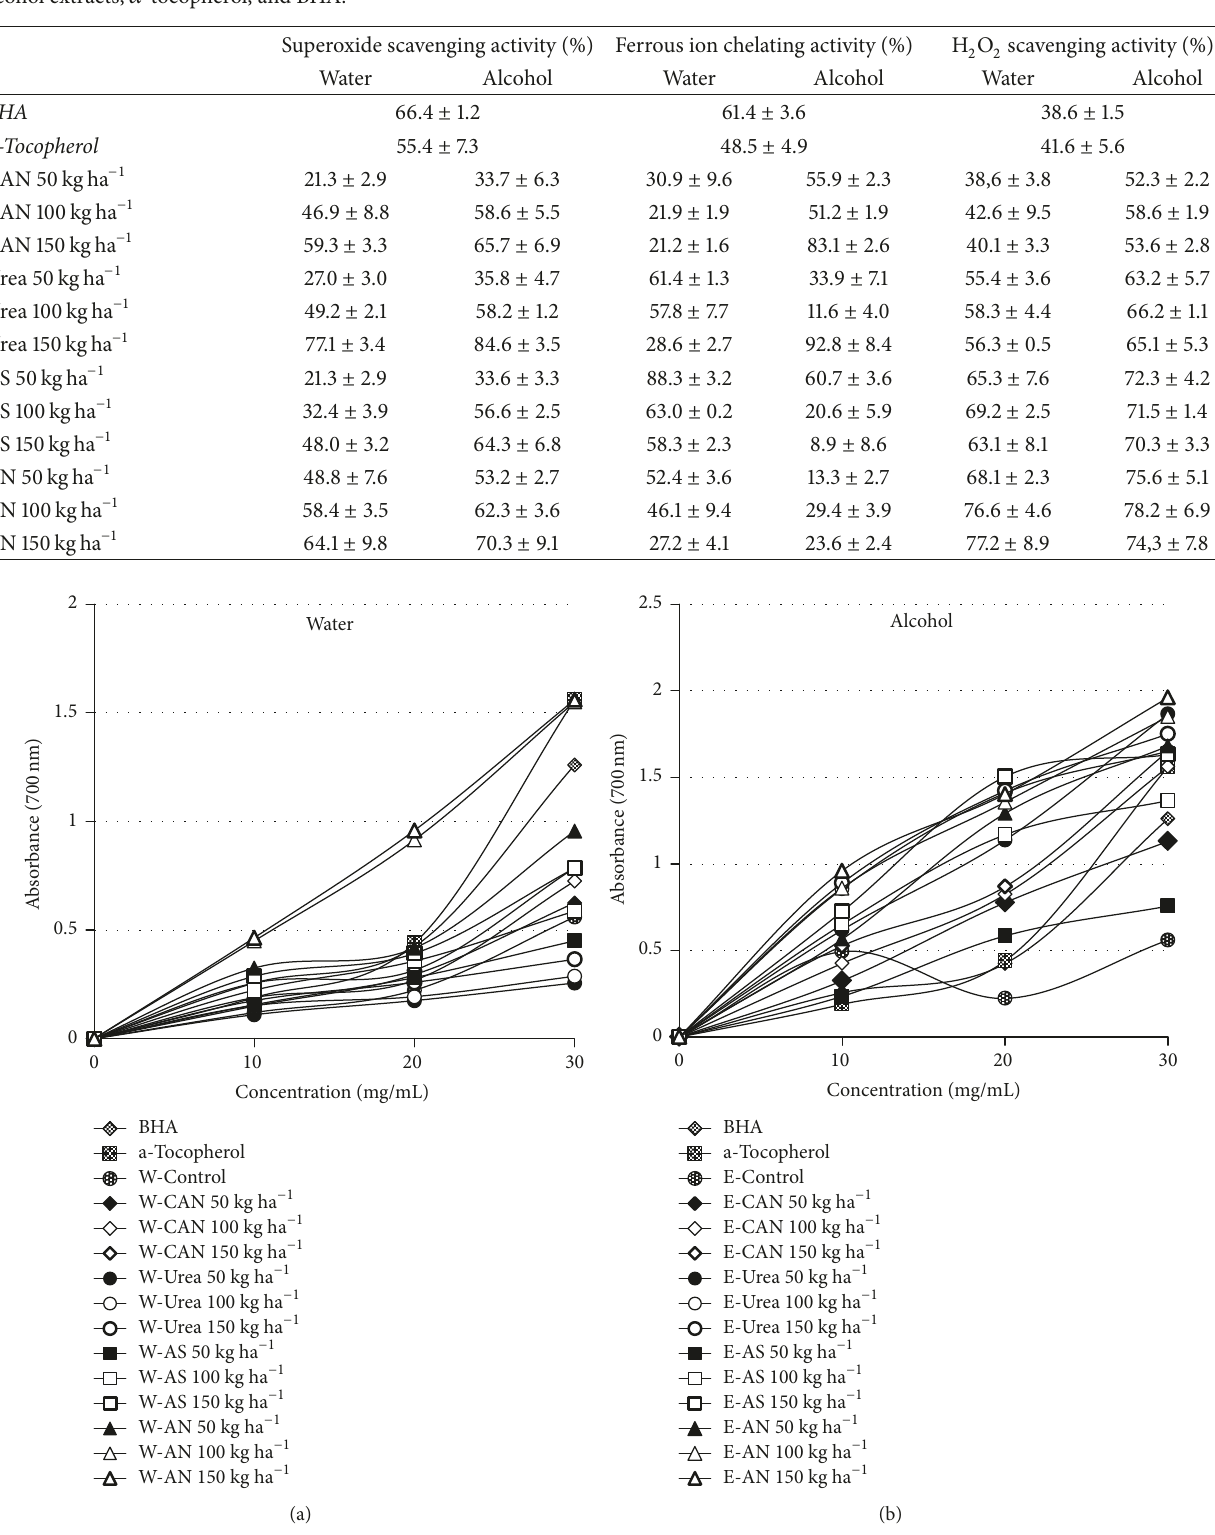
Table2:Theresultsofsuperoxideanionradicalscavenging,ferrousionchelating,andhydrogenperoxidescavengingactivityofwaterextracts, alcohol extracts, 𝛼 -tocopherol, and BHA.